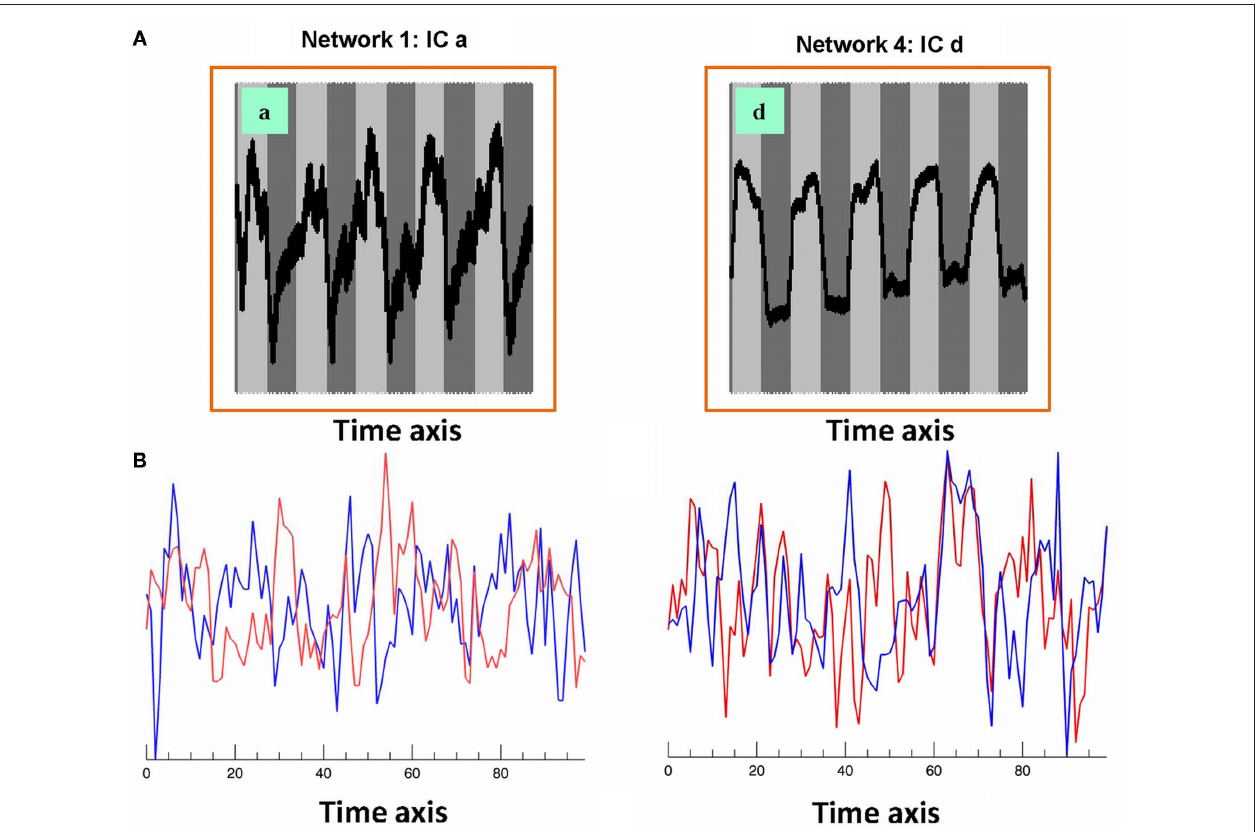
FIguRe 2 | (A) Associated averaged time courses from two group IC networks shown in Figure 1 . Horizontal axis is time and the vertical axis is intensity ( pseudo ). Gray and white background indicates the timing of the task reference function; (B) associated IC time courses from two subjects